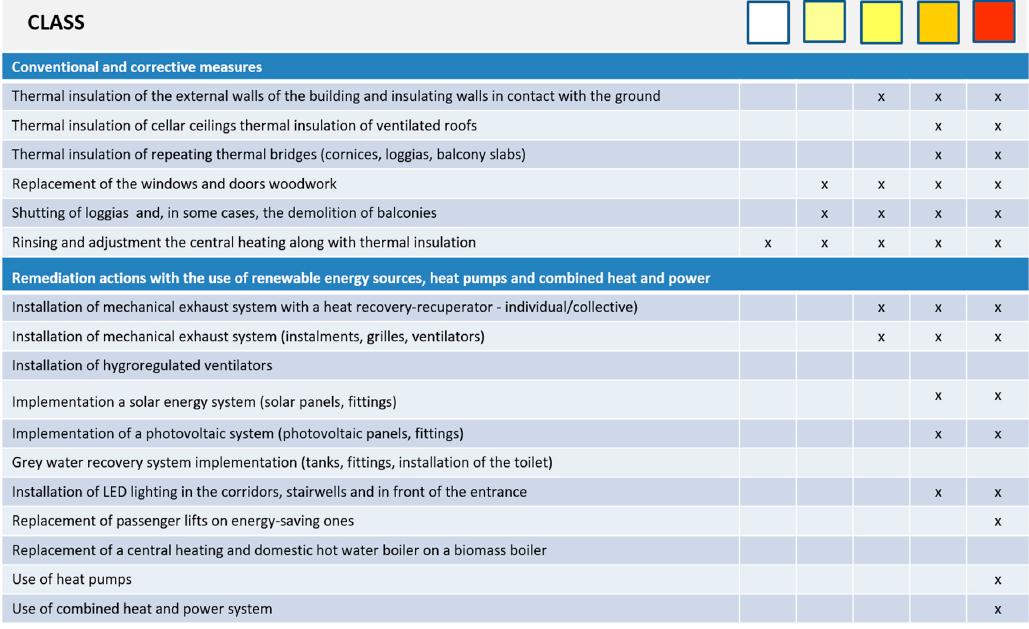
Figure 3. Activities that the inhabitants of Zielona Góra were asked about and their potential willingness to participate in them and incurring financial expenses.